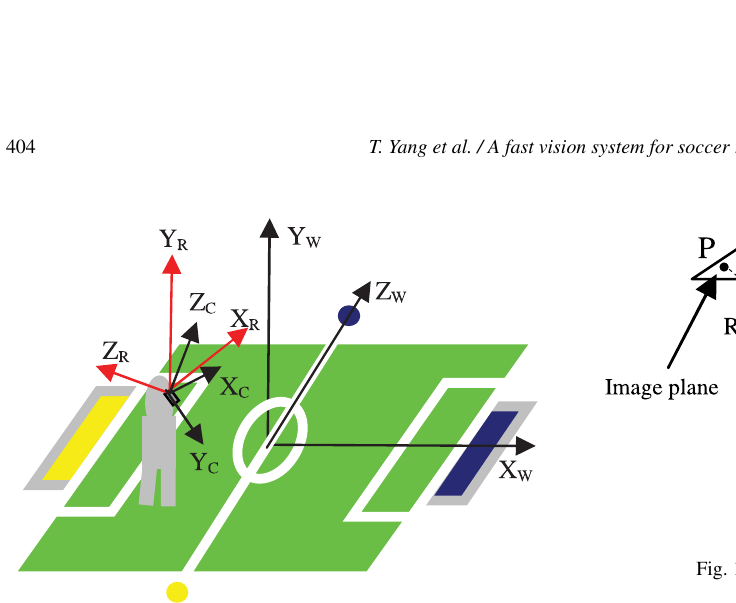
Fig. 8. The coordinate systems used in the object localization.